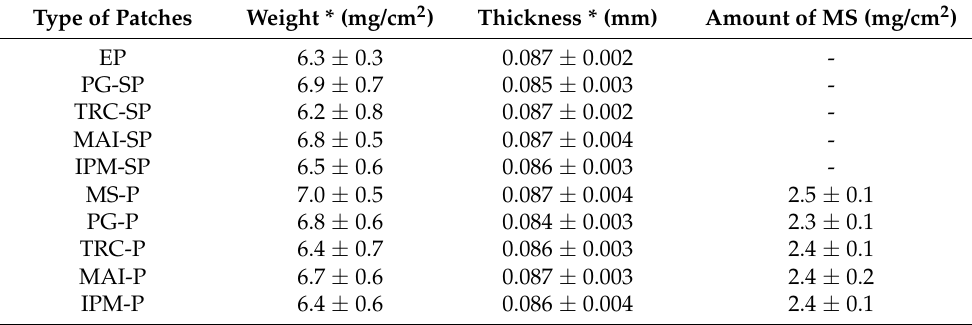
Table 3. Patch weight, thickness (n = 10, mean ± SD) and drug content (n = 3, mean ± SD) for different patches prepared with and without solvent and/or drug (PG: propylene glycol; TRC: Transcutol ® P;